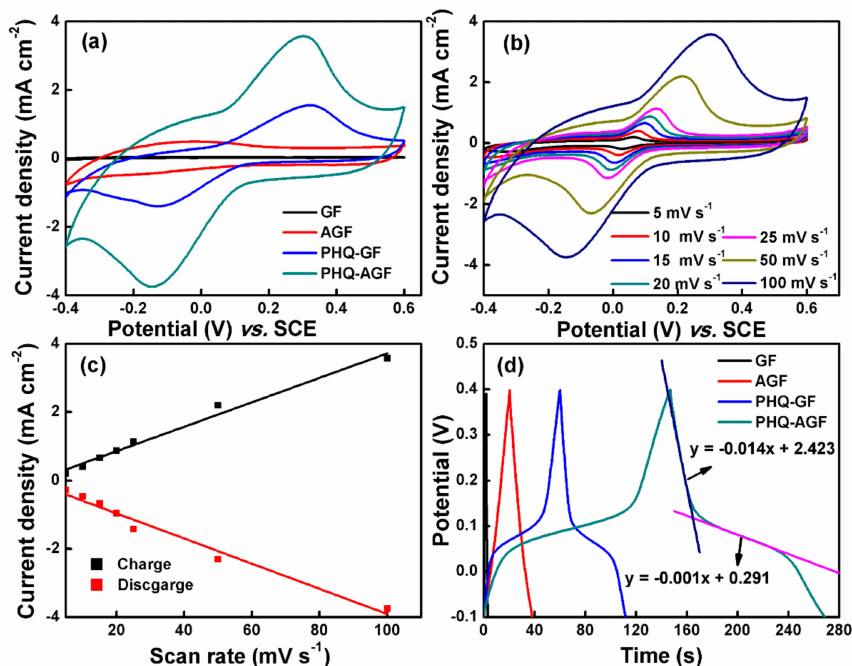
Figure 1. ( a ) CV profiles of the GF, AGF, PHQ–GF, and PHQ–AGF electrodes at a scan rate of 100 mV s − 1 ; ( b ) CV profiles of the PHQ–AGF electrode at the scan rate ranging from 5 to 100 mV s − 1 ; ( c ) Plot of Faradaic peak currents vs. scan rates derived from the CVs of the PHQ–AGF electrode; ( d ) GCD profiles of the GF, AGF, PHQ–GF, and PHQ–AGF electrodes at a current load of 0.08 mA cm − 2